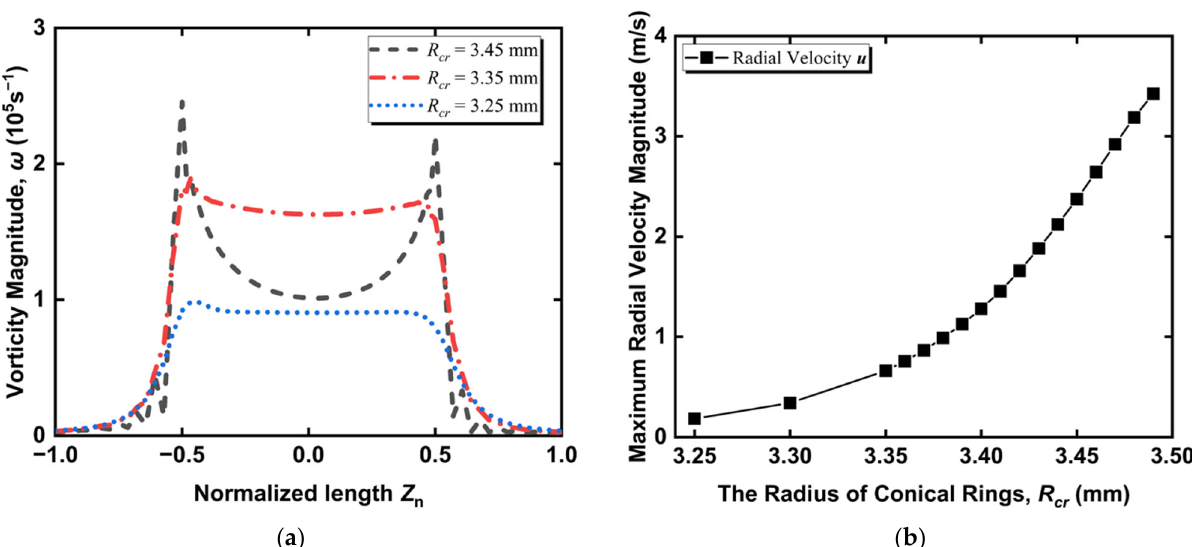
Figure 10. The influence of the conical ring radius on ( a ) the vorticity magnitude distributions and ( b ) maximum radial velocity magnitude.